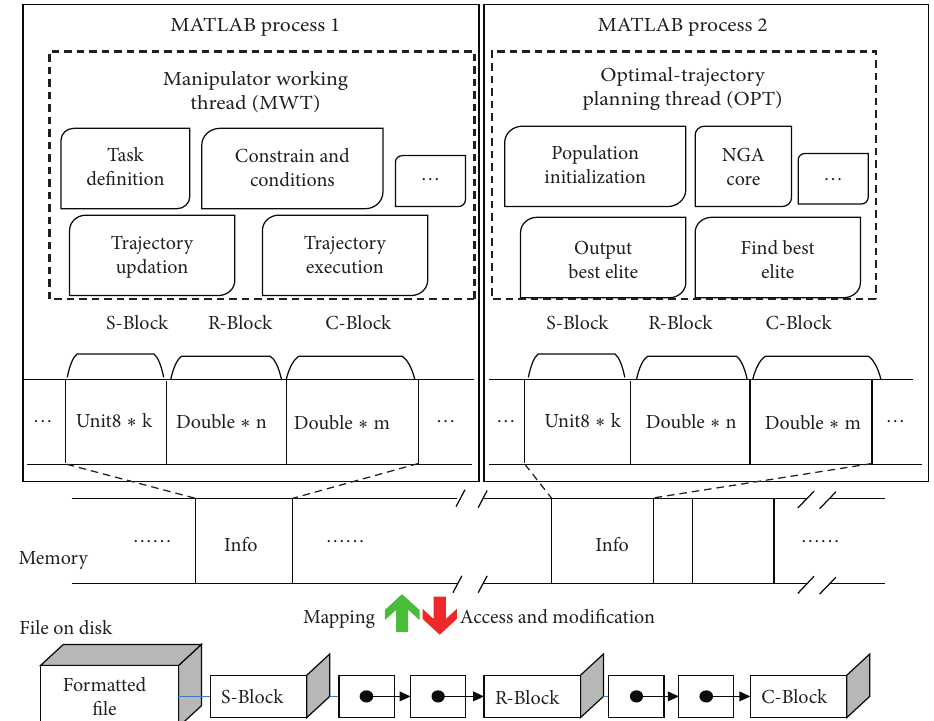
Figure 4: Simulation of dual-thread framework using two MATLAB processes.